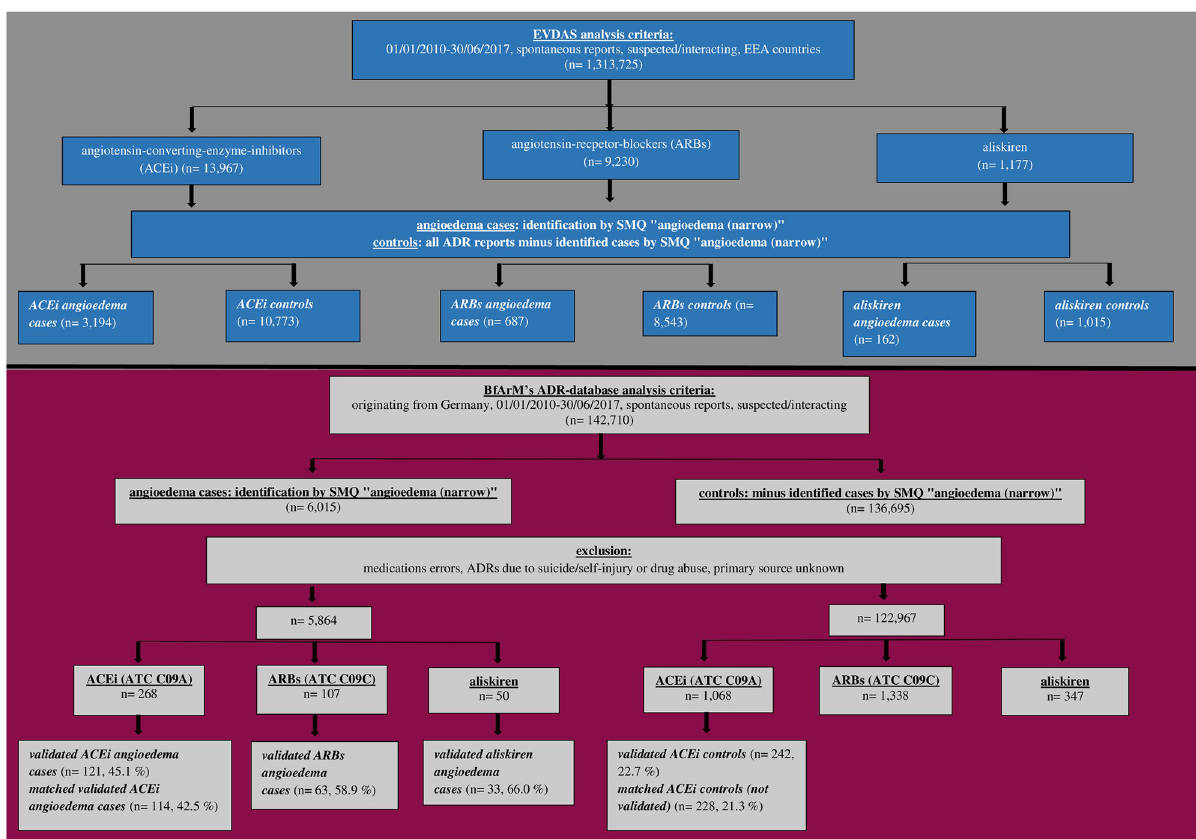
Fig 1. Flowchart. Fig 1 represents the number of cases identified for ACEi , ARBs and aliskiren angioedema cases and their respective controls in EVDAS and BfArM’s ADR-database.